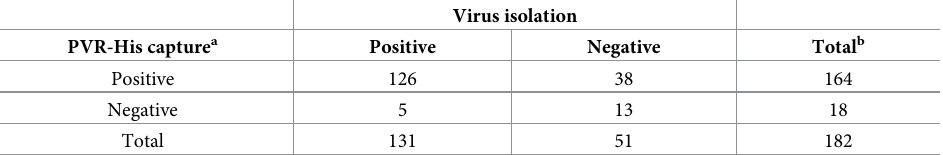
Table 5. Two-by-two table comparison of poliovirus detection in the culture-independent detection method (PVR-His capture) followed by RNA extraction and standard virus isolation. Results from a total of 182 stool speci- mens are shown that were selected on the results from previous testing for poliovirus in virus isolation, ITD PCR, and VP1 sequencing (Table 1). Virus isolation PVR-His capture a Positive Negative Total b Positive 126 38 164 Negative Total 131 51 182 a Any poliovirus detected in ITD suite of PCR assays were scored positive (including invalid and indeterminate results). Samples that were negative in all ITD assays were scored negative for poliovirus. b Sensitivity: 96.2%, specificity: 25.5%, (Predictive value positive [PVP] 76.8%, predictive value negative [PVN]: 72.2%); McNemar χ 2 with continuity correction P =